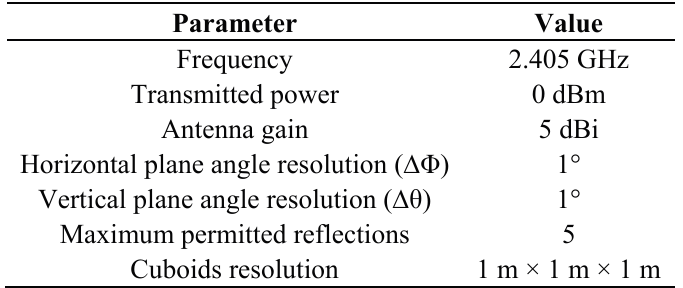
Table 1. Considered parameters for the Ray Launching